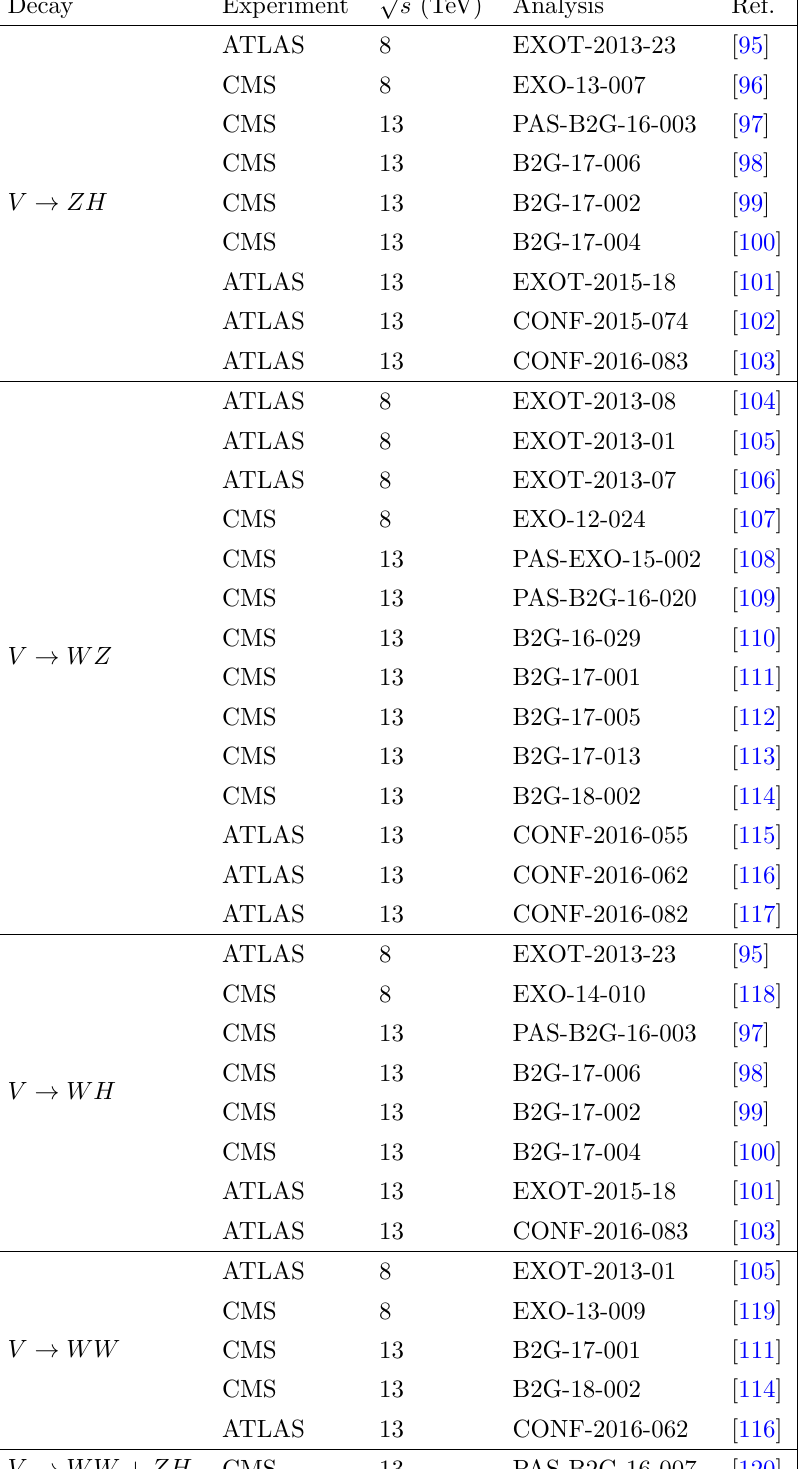
Table 9. Experimental analyses of bosonic decay channels of vector resonances we use to judge the fitness of our